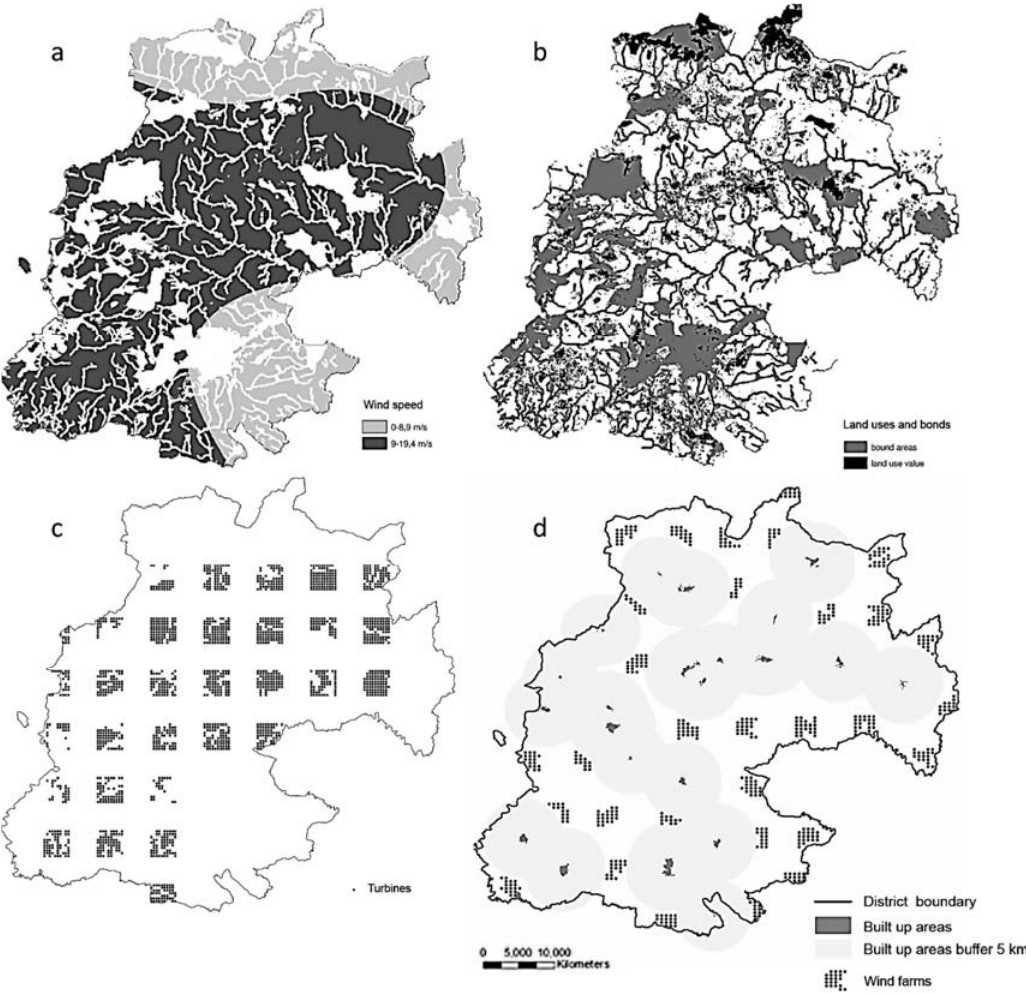
Figure 8. Suitable areas in the Province of Enna (our GIS elaboration). ( a ) Hydrographic basins and anemometry. ( b ) Land uses and bond areas. ( c ) General scheme of the plant areas before considering built-up areas buffer zone. ( d ) Allowed plant areas.